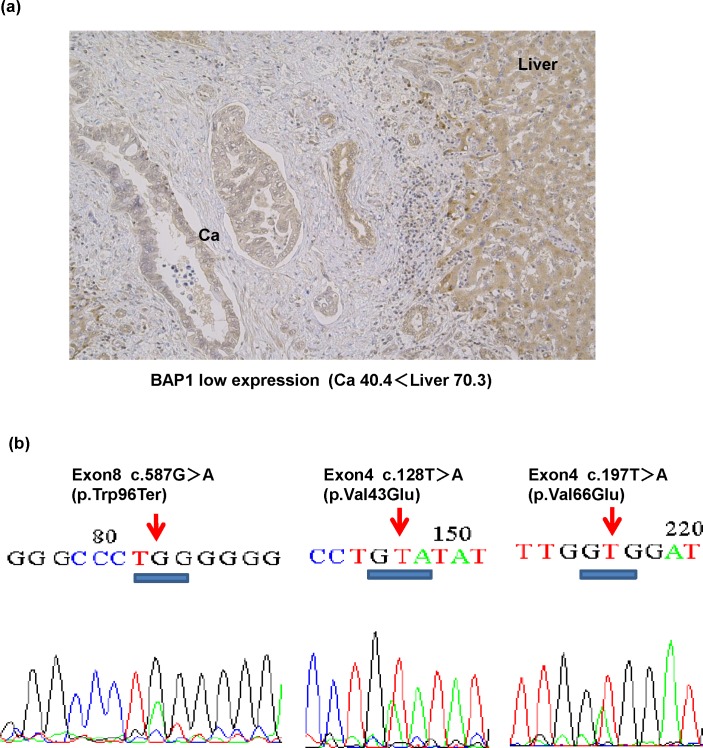
BAP1 expression and detected mutations in clinical GBC (ID 12).(a) Since the BAP1 staining concentration was low in the cancer part (Ca 40.4 < Liver 70.3), ID12 was categorized to the BAP1 low expression group. (b) The nonsense mutation on exon 8 (c.587G>A (p.Trp96Ter)) and the missense mutation on exon 4 (c.128T>A (p.Val43Glu), c.197T>A (p.Val66Glu)) were observed.